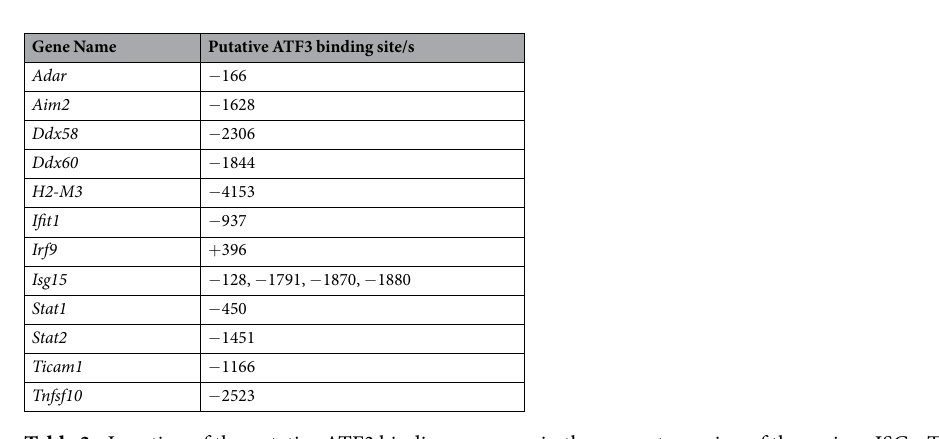
Table 3. Location of the putative ATF3 binding sequence in the promoter region of the various ISGs. The − 5 kb to + 1 kb region of the gene containing the putative promoter elements was scanned for the ATF3 binding motif (TGACGTCA) using an in-house written python script. The position of putative ATF3 binding sites relative to the transcription start site in the various ISGs is